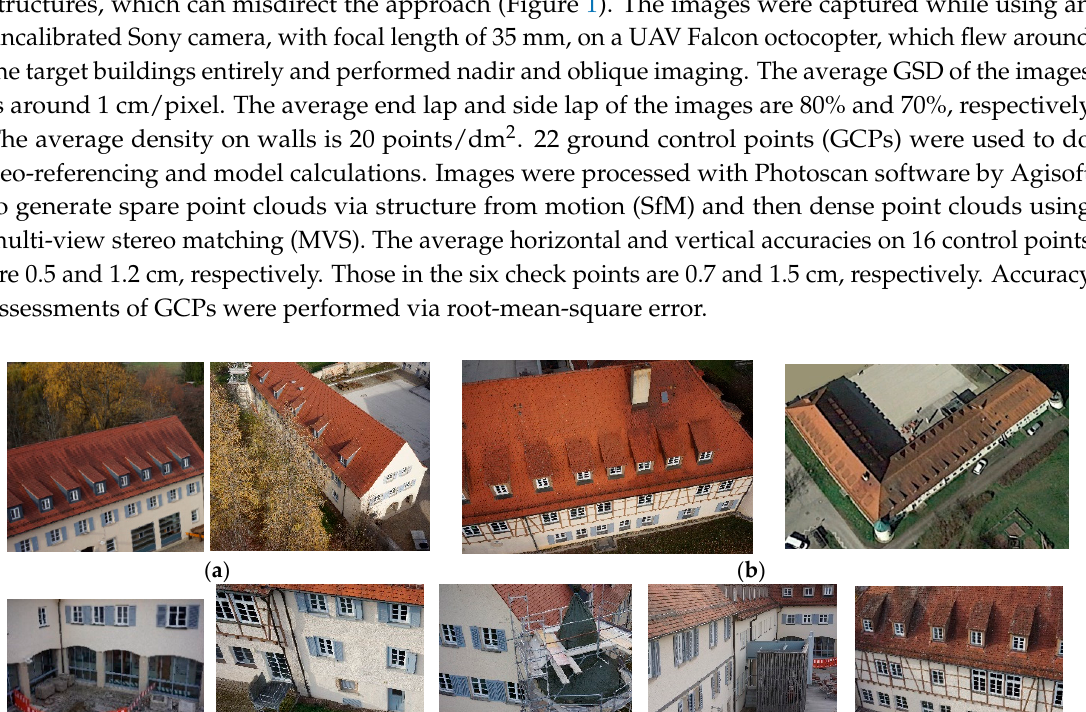
Figure 2. The different window types considered in this study.